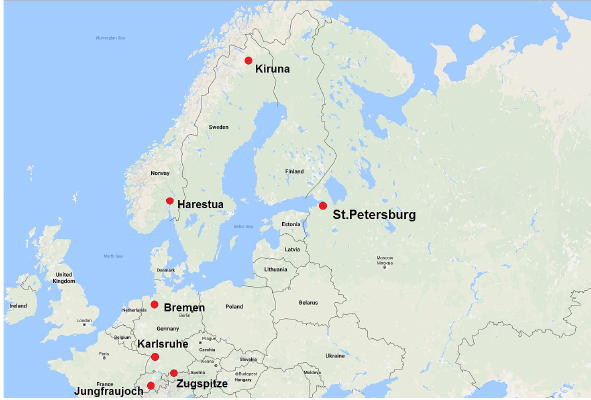
Figure 1. Location of NDACC IRWG sites in Europe (red